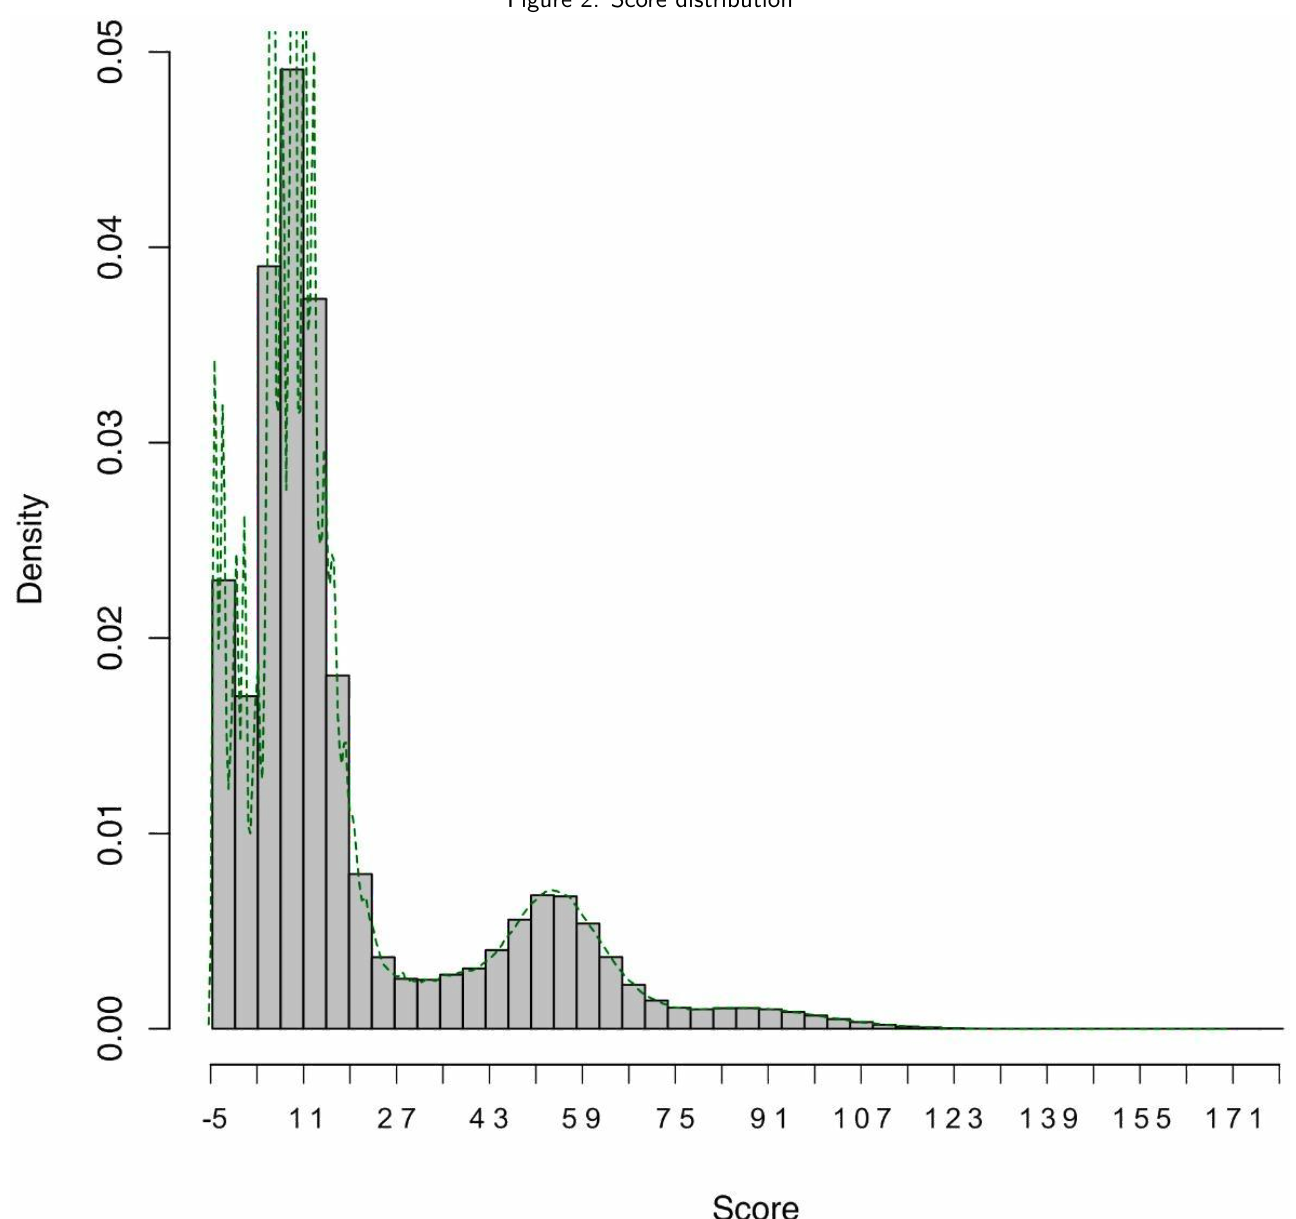
Figure 2: Score distribution